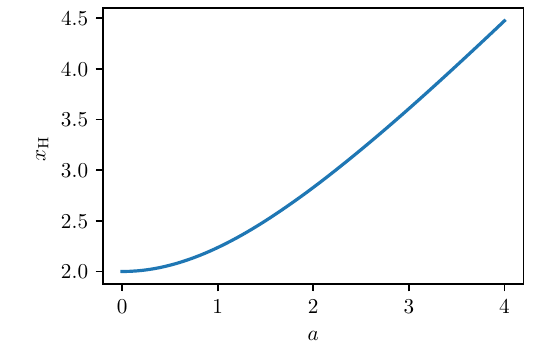
Fig. 1 The (dimensionless) radius of the event horizon for the quan- tumdeformedblackholechangeswiththe(dimensionless)deformation